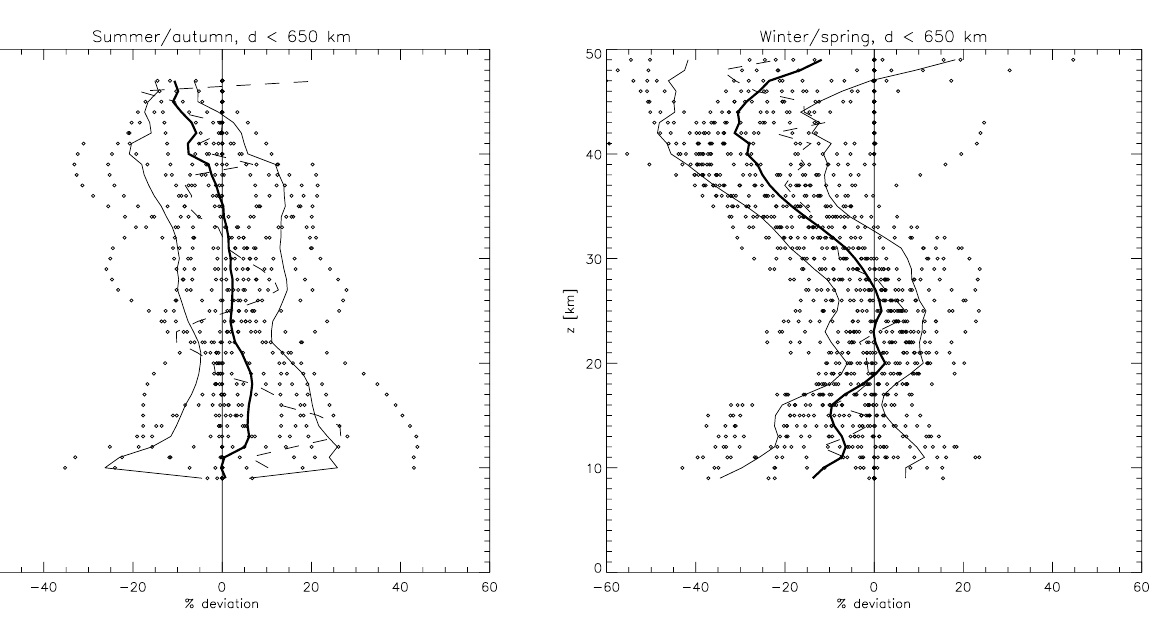
Fig. 4. As Fig. 3, with 650 km radius, but only for the months of August and September.